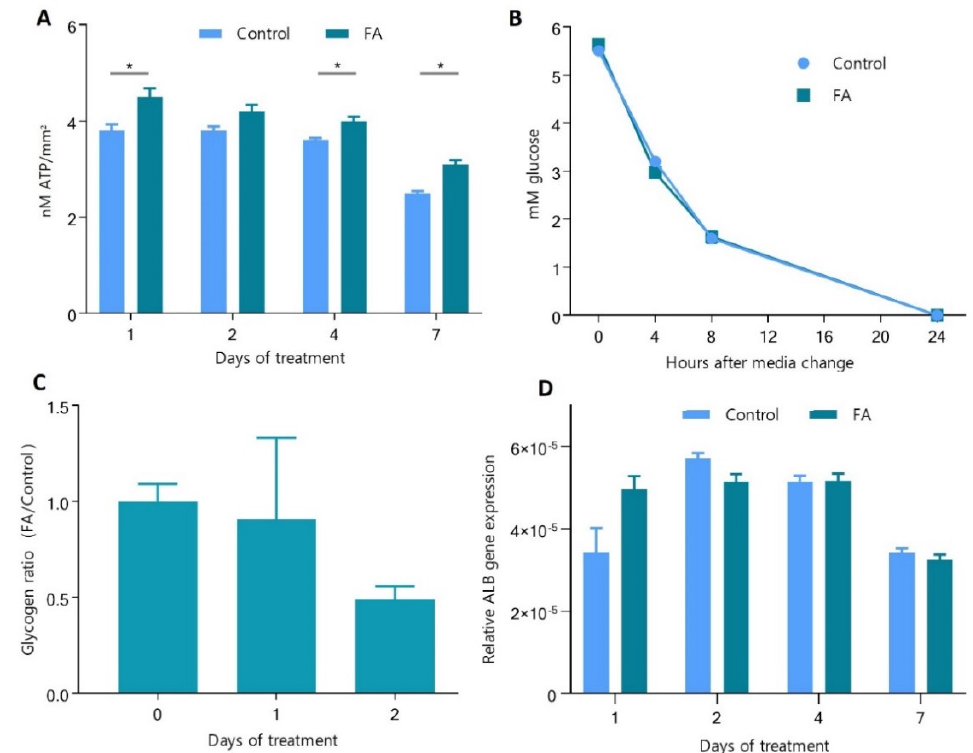
Figure 3. The effect of palmitic and oleic acids on hepatocyte function. FA-spheroids treated with 45 μM palmitic acid and 65 μM oleic acid, Control-spheroids in standard growth media. ( A ) ATP level in spheroids normalized by spheroids surface ( n = 3). ( B ) Glucose consumption was measured in culture media from spheroids pre-exposed to FA for 4 days. It was followed at 0, 4, 8, and 24 h after supplementation with a fresh cell culture media ( n = 3). ( C ) Glycogen deposition ratio in 21-day-old spheroids after 0, 1, and 2 days of FA exposure normalized to spheroids size and a respective control ( n = 3). ( D ) Albumin gene expression after 1, 2, 4 and 7 days of treatment with FA ( n = 6). * statistically significant difference between Control and FA-treated spheroids at the indicated timepoint, Student’s t-test and Holm-Sidak post hoc test, p < 0.05. Error bars show the standard error of the mean.